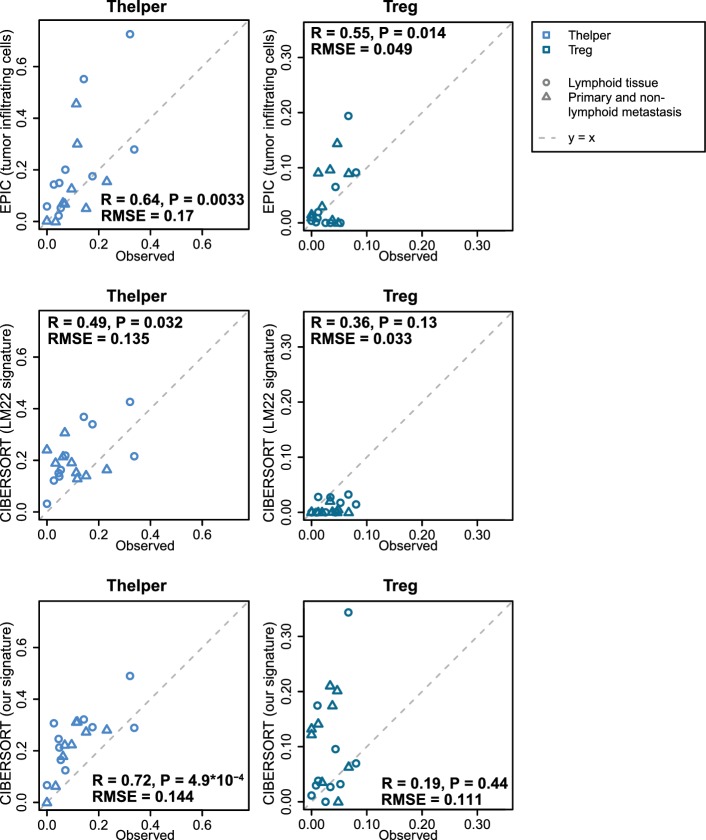
Predicting Thelper and Treg cell fractions in tumors.The proportions of Thelper and Treg cells predicted by EPIC and CIBERSORT are compared to the proportions observed in the bulk samples reconstructed from the single-cell RNA-seq data from melanoma tumors (Tirosh et al., 2016). Pearson correlations and RMSE are indicated on the figures.